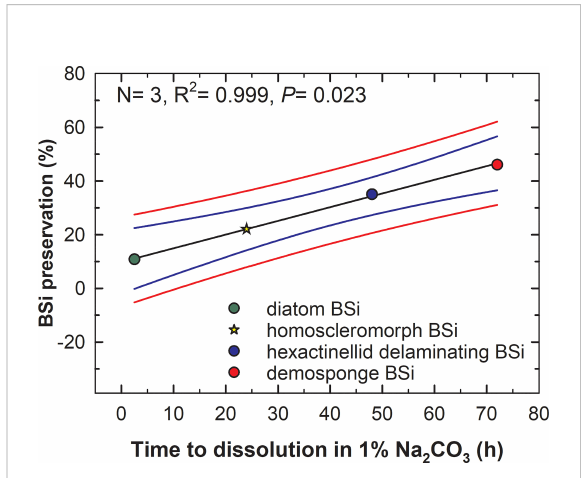
FIGURE 9 Relationship between the time (h) required by the various types of BSi (diatoms, rosellid hexactinellids, demosponges) to dissolve completely in 1% sodium carbonate at 85°C and their respective preservation (%) in the marine sediments. The relationship is best fi tted by a linear regression model (black line) in the form of “ Preservation (%) = 10.04 + (0.5×dissolution time) ” , which is statistically signi fi cant (see extended statistics in Supplementary Results S3). Blue and red lines indicate the 95% con fi dence band and the 95% prediction band of model, respectively. The preservation of the silica of homoscleromorph sponges relative to its deposition is predicted to be around 22.12 ± 1.38% (yellow start) as a function of its resistance to dissolution in sodium carbonate (Figure